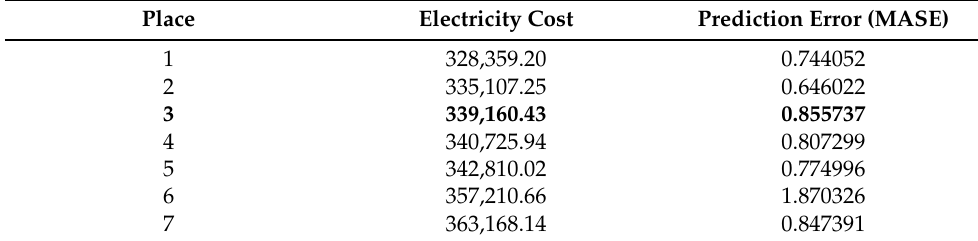
Table 1. Top seven entries of the final leaderboard. Our entry is highlighted in bold.